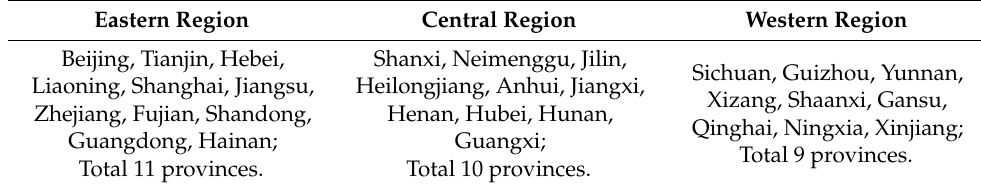
Table A1. China’s provincial administrative divisions (eastern, central, and western regions). Eastern Region